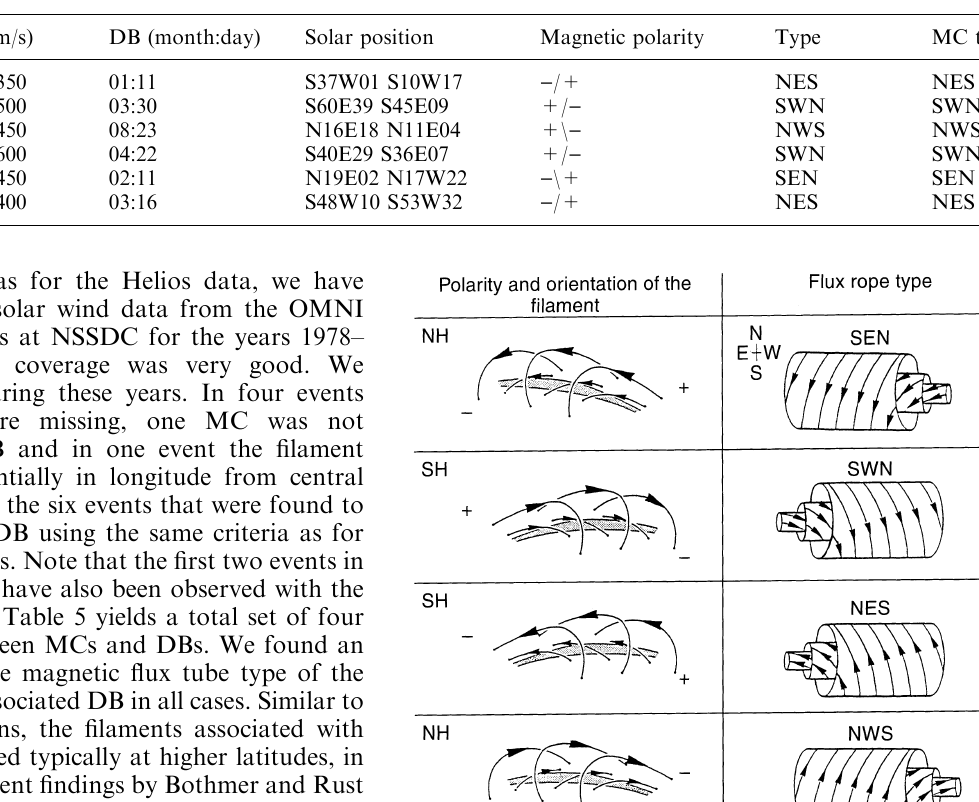
Table 5. Associations between MCs observed with near Earth spacecraft (OMNI database) and DBs during 1978–1980. Left to right: date of MC, speed range of MC, date of associated DB, solar position of DB, magnetic polarity of DB, inferred DB flux tube type, MC flux tube